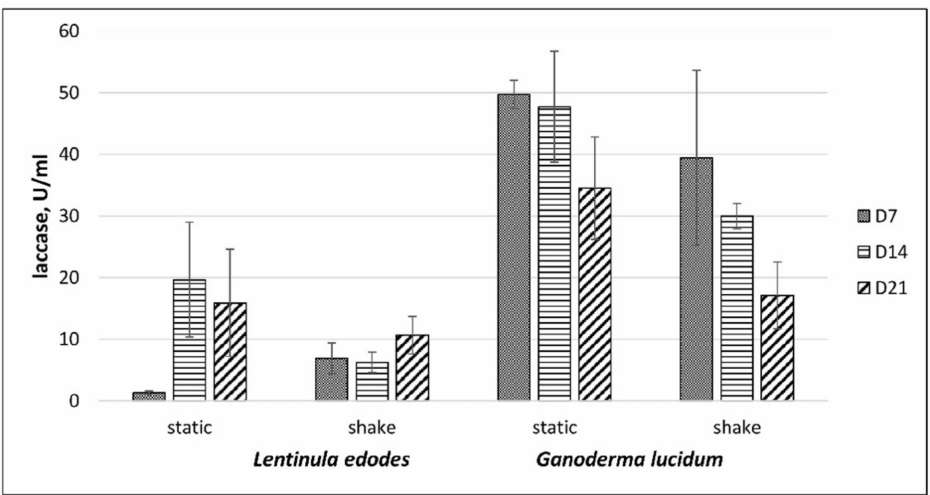
Figure 4. Laccase activity of L. edodes and G. lucidum grown in control MEB liquid media under shaken and static conditions. D7 and D21—period of incubation (days).